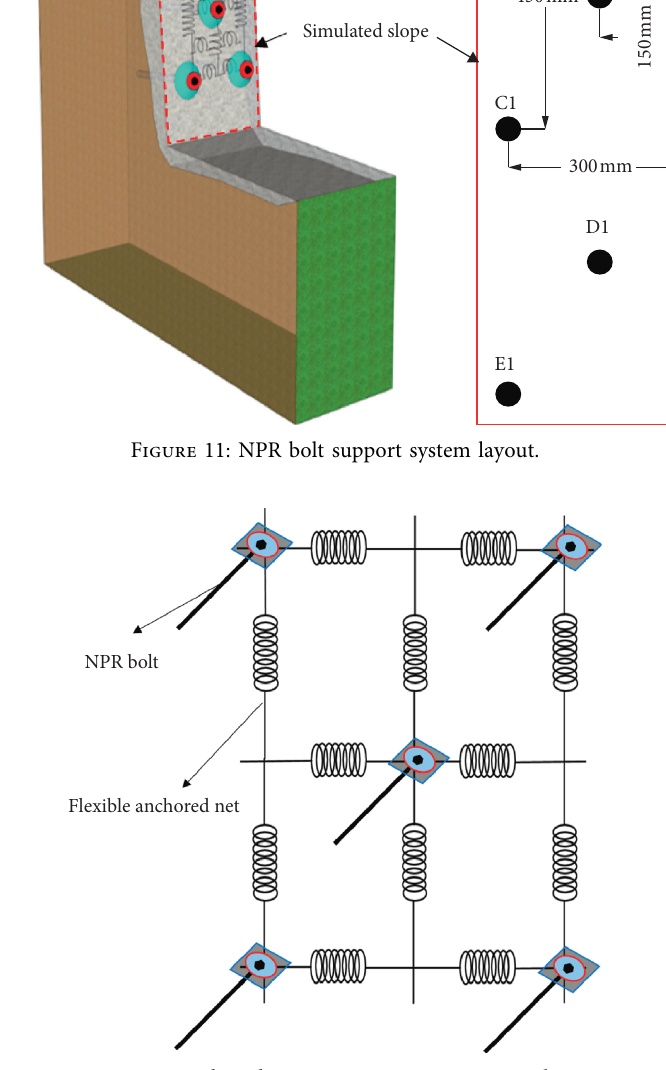
Figure 12: Anchored net structure support system layout.